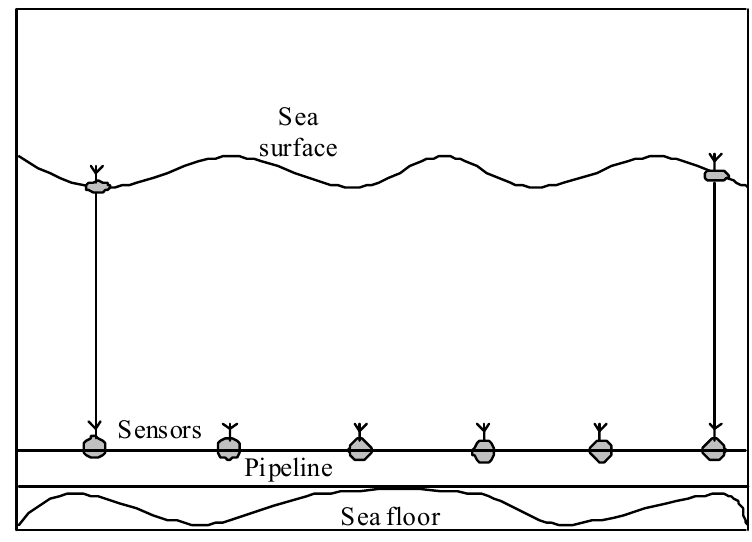
Figure 4. Underwater acoustic sensor